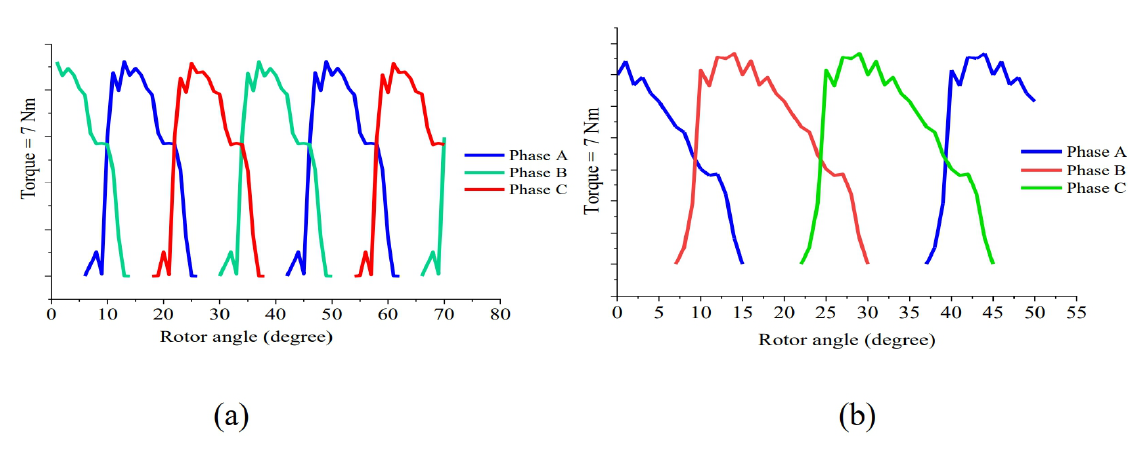
Fig. 6. SRM Torque ripple analysis (a)10/6, (b)